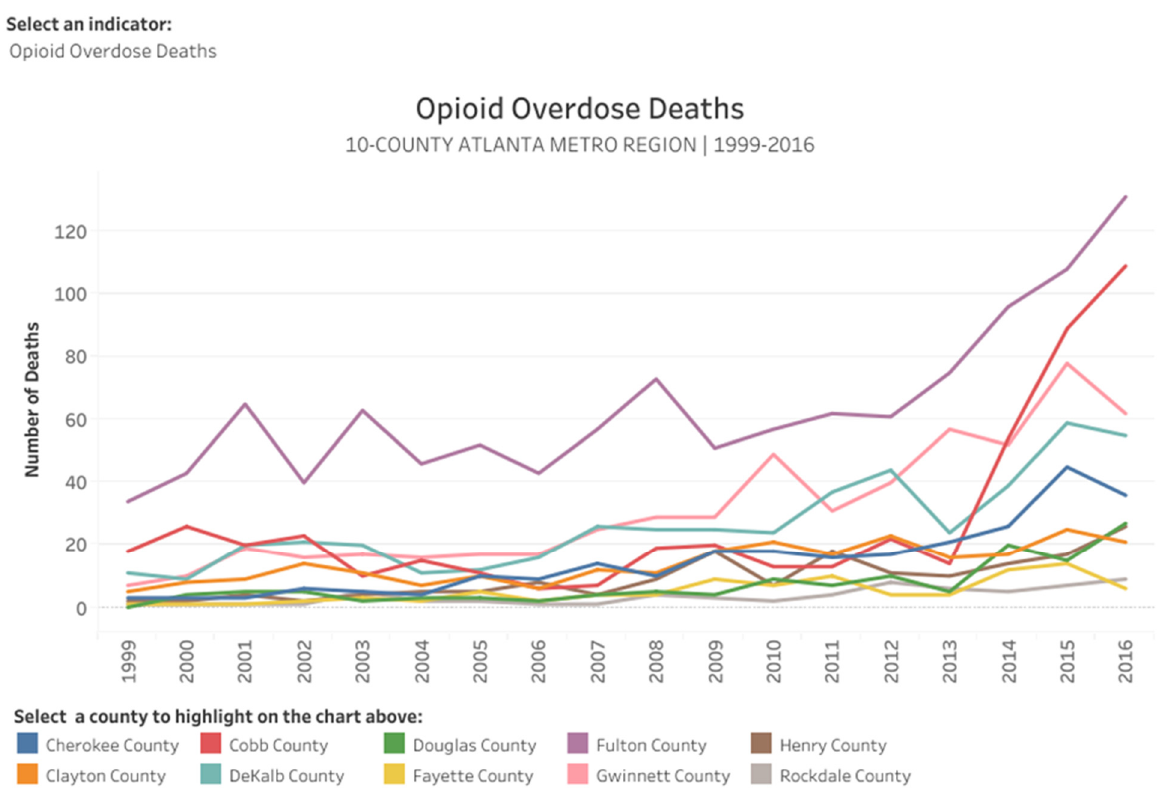
Figure 1. Opioid overdose deaths in Metro Atlanta from 1999 to 2016. Data adapted from the Atlanta Regional Commission (ARC) 2018 [4].